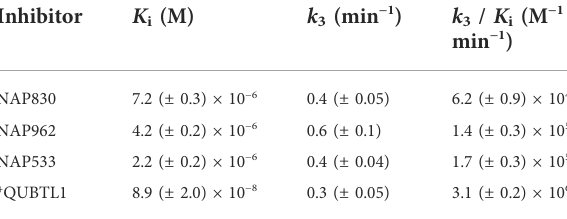
TABLE 2 Kinetic constants for the inhibition of plasmin by various